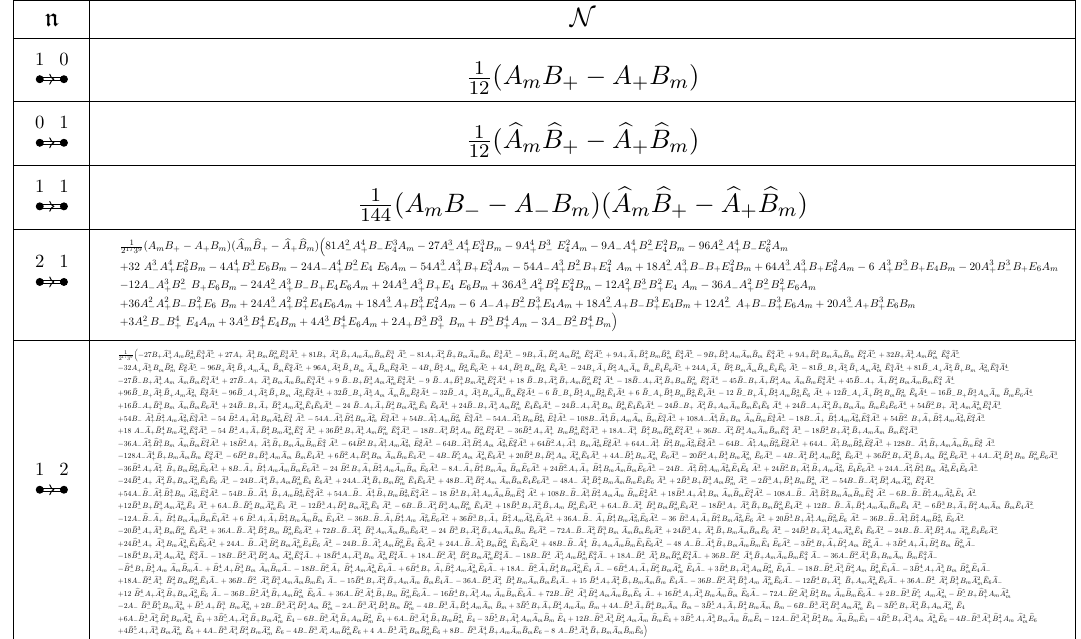
Table 8 . Elliptic genera of B 2 . Here, A z = A z ( τ ) , b A z = A z (2 τ ) , and same for B z